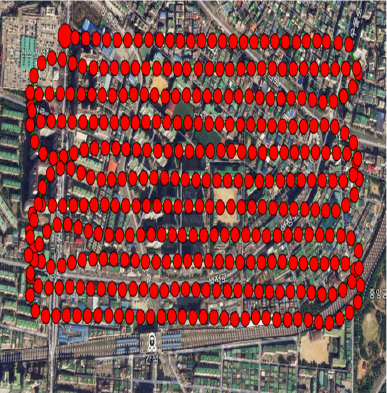
Figure 8. Top view of the flight path of the UAV (green line) and the locations of the images acquired (red dots) .